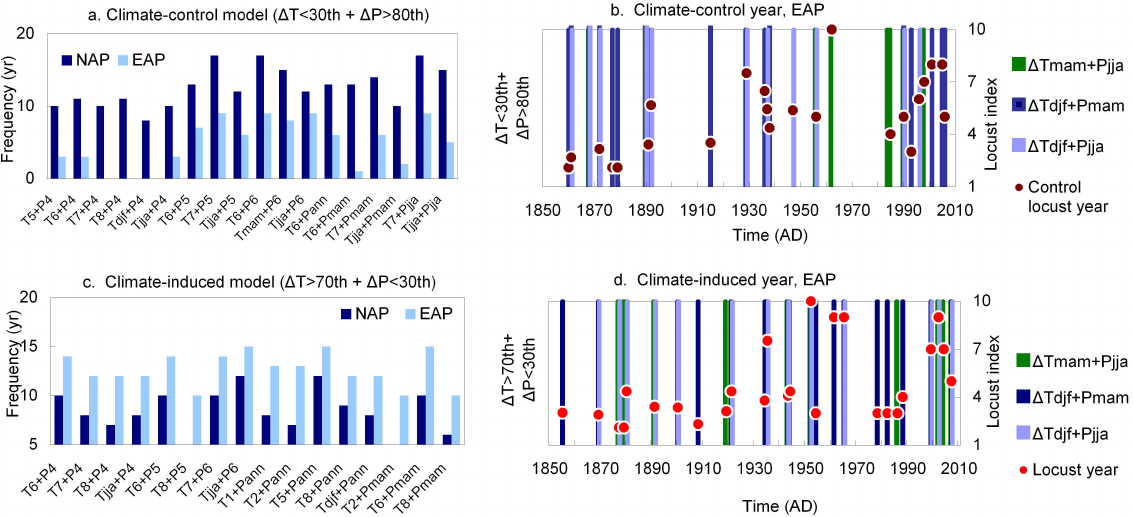
Fig. 3. Frequency comparisons of extreme climatic combinations between the NAP and EAP (a, c) and validation with EAP locust outbreak years (b, d) , including the climate-controlled model with 1T < 30th and 1P > 70th percentiles (a) , climate-induced model with 1T > 70th and 1P < 30th percentiles (c) , year comparisons of locust outbreak with warm–dry extremes ( 1T > 70th and 1P > 30th) (d) , and cold–wet extremes ( 1T < 30th and 1P > 80th) (b) . All climate variable abbreviations are the same as in the